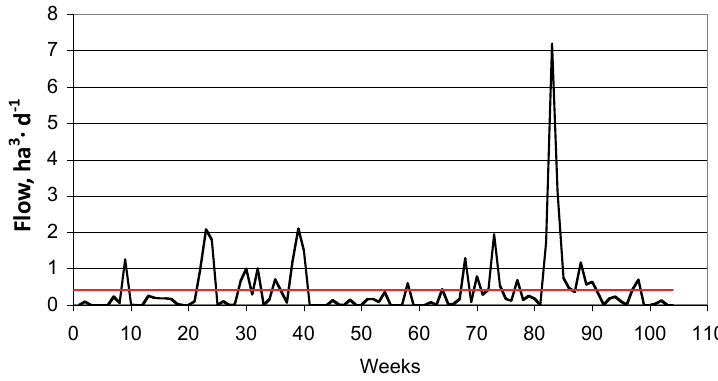
Figure 4. Weekly average flow entering STA1West over a two year POR (period of record) (2011–2013). The mean daily flow was 0.42 ha 3 ·day − 1 . Flow occurred on 30% of the days, at a mean rate of 1.38 ha 3 ·day − 1 .